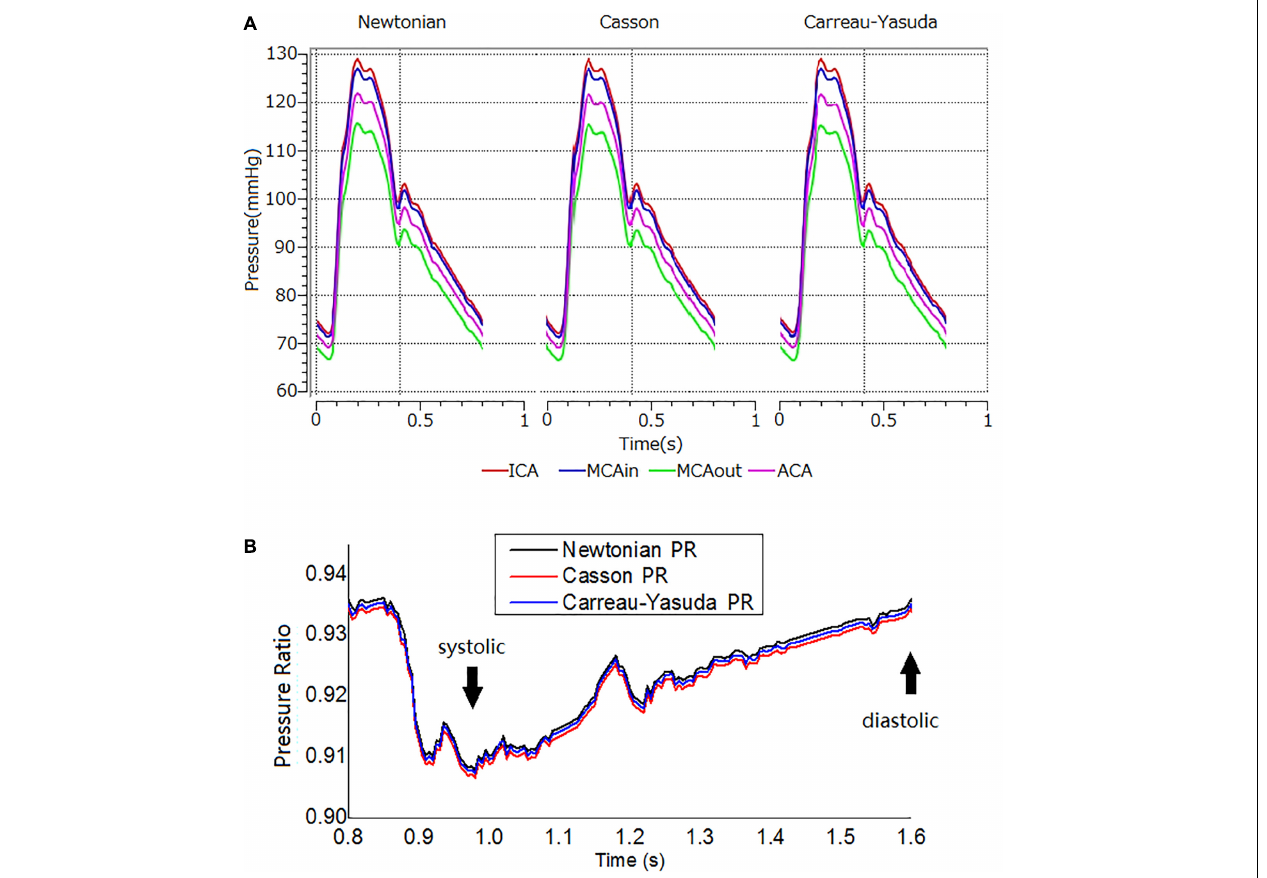
FIGURE 4 | The transient pressure and PR distribution. (A) Transient pressure curves in the ICA-MCA-ACA branching model with Newtonian, and Casson, and Carreau-Yasuda rheological models in a cardiac cycle. The simulations lasted for three cardiac cycles. The results are from the second cardiac cycle. The positions of measurement are shown in Figure 1C . (B) The transient PR curves in Newtonian, Casson, and Carreau-Yasuda models during the second cardiac cycle. PR was calculated as the area-averaged pressure at MCAout divided by the area-averaged pressure at MCAin (locations of MCAout and MCAin are shown in Figure 1C ).